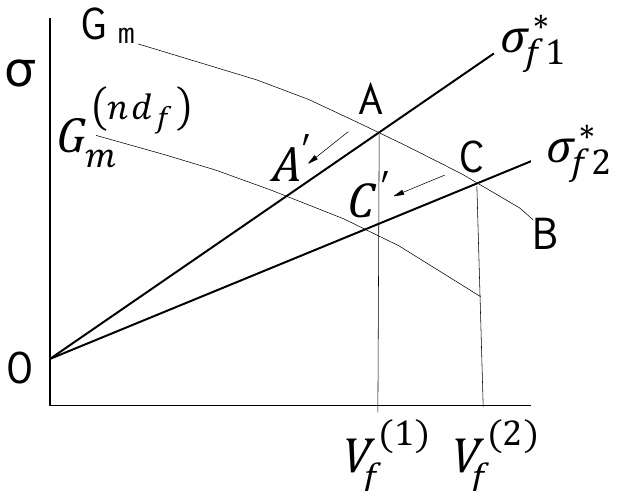
Figure 1. Schematic of the strength/fibre-volume-fraction dependence for metal-matrix fibrous composites (see the text). 𝜎 𝑓1∗ > 𝜎 𝑓2∗ .